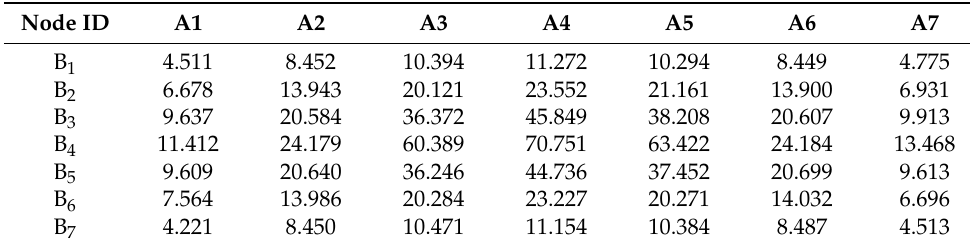
Table 7. Displacement values obtained from the simulation. Node